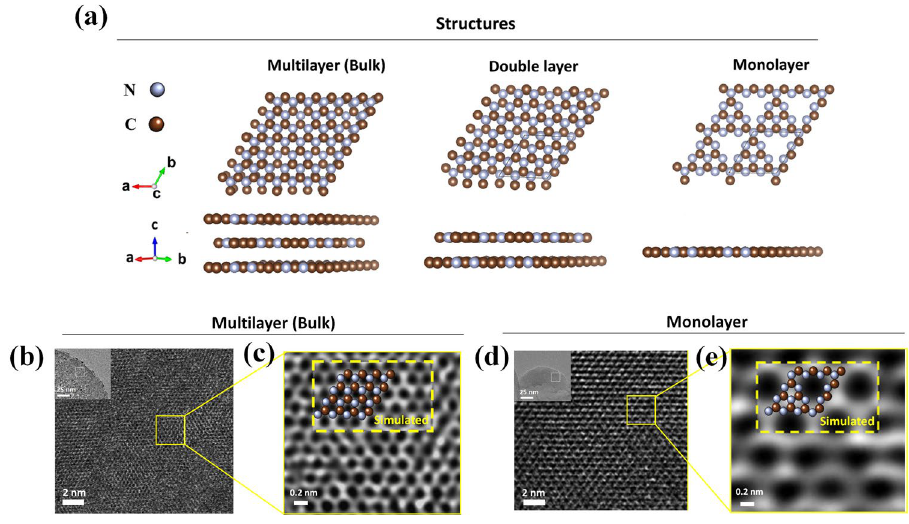
Fig. 3 Experimentally observed and theoretically simulated atomic structures for g‑C 3 N 4 –b and g‑C 3 N 4 –m. a Schematic presentation of multi‑ layer (bulk), double layer and monolayer structures of g‑C 3 N 4 . b, d Cs‑HRTEM images of g‑C 3 N 4 –b and g‑C 3 N 4 –m, respectively. The insets are low‑magnification TEM images. c, e Wiener‑filtered Cs‑HRTEM images experimentally observed, which are magnified from the yellow box in b and d. The insets are the images theoretically simulated (yellow dashed box) with the atomic model overlaid of g‑C 3 N 4 –b and g‑C 3 N 4